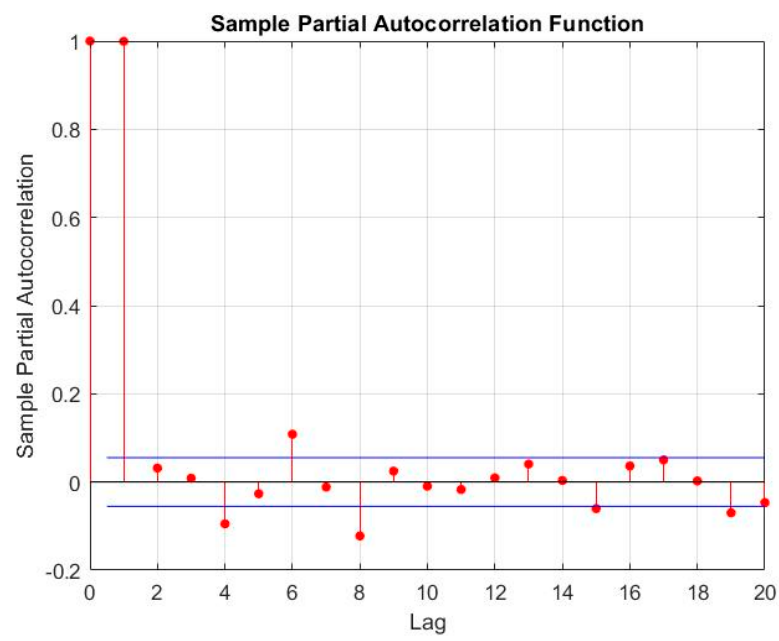
Figure 4. BTC–USD: PACF analysis.